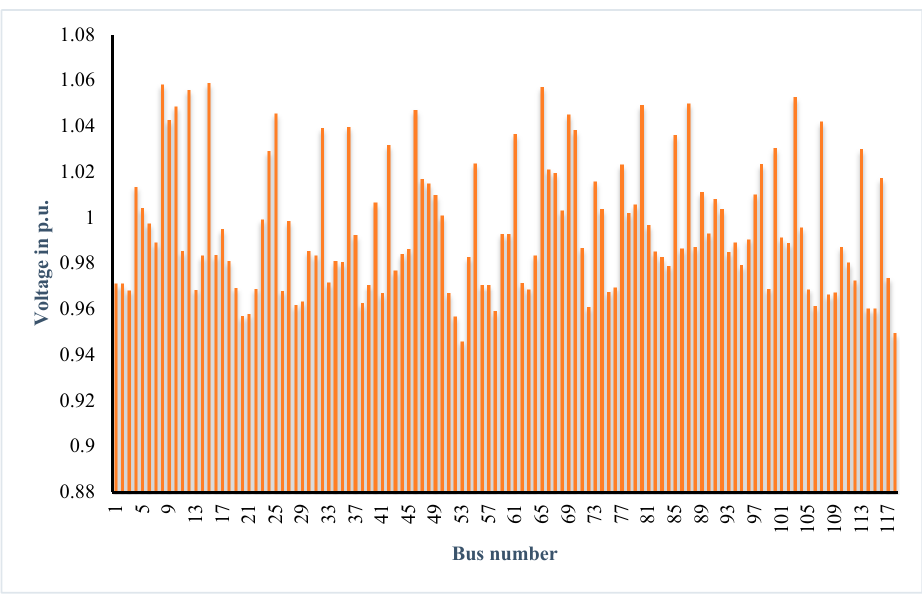
Figure 8. Power loss reduction for IEEE 118-bus system.